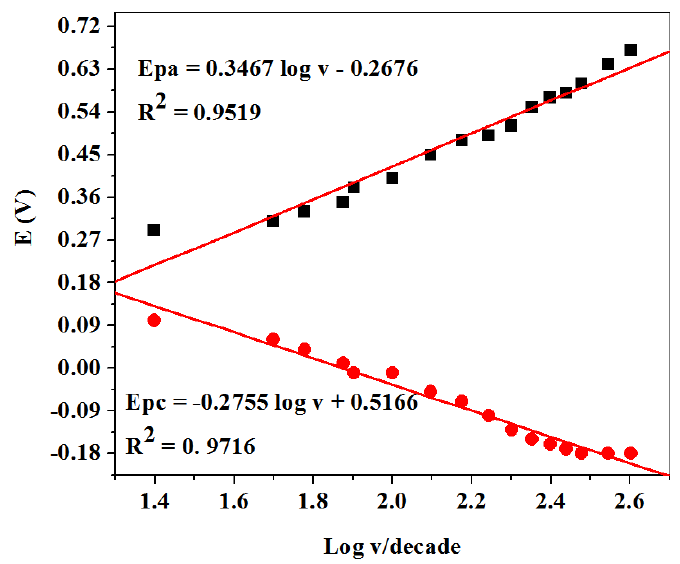
Figure 11. Linear plots of peak potential vs. logarithm of scan rate at SPCE-Fe 3 O 4 /SPEEK for DA prepared in 0.1 M PBS (pH 7.4).